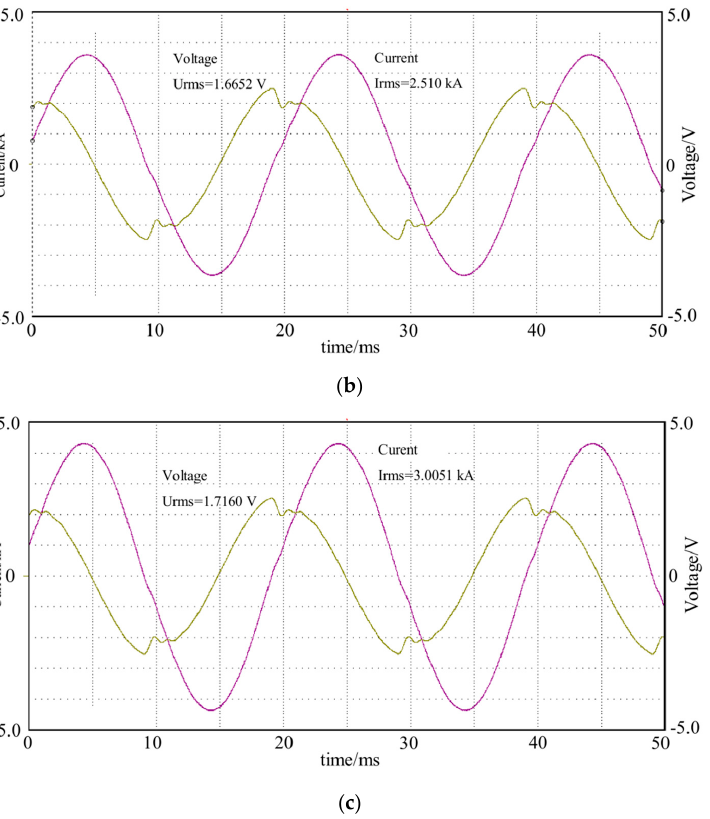
Figure 12. AC operating current test curve: ( a ) phase A (2.9532 kA/2.5270 V); ( b ) phase B (2.510 kA/1.6652 V); ( c ) phase C (3.0051 kA/1.760 V).